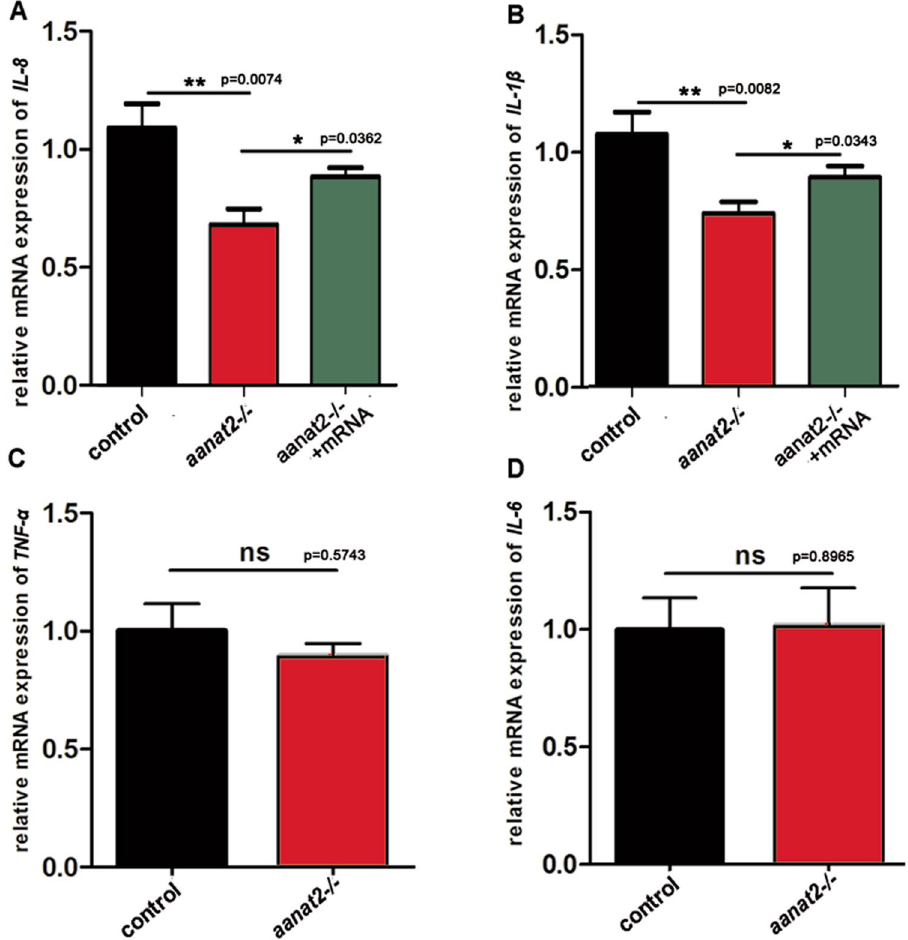
Figure 6. Down-regulation of cytokine expression in aanat2 − / − fish. ( A – D ) Zebrafish embryos (4 days post fertilization) were collected for RNA extraction at 1.5 h after injury in the darkness. qRT-PCR analysis showed significantly down-regulation of il-1 β and il-8 , which could be partly rescued by injection of aanat2 capped mRNA (one way ANOVA analysis). However, tnf- α and il-6 expressions showed no significant difference between the aanat2 − / − and control groups (unpaired t -test). Each independent sample contained fifty embryos. The data were analyzed using three samples in both the control and mutant groups. The experiment was repeated three times. ( * P < 0.05, ** P <